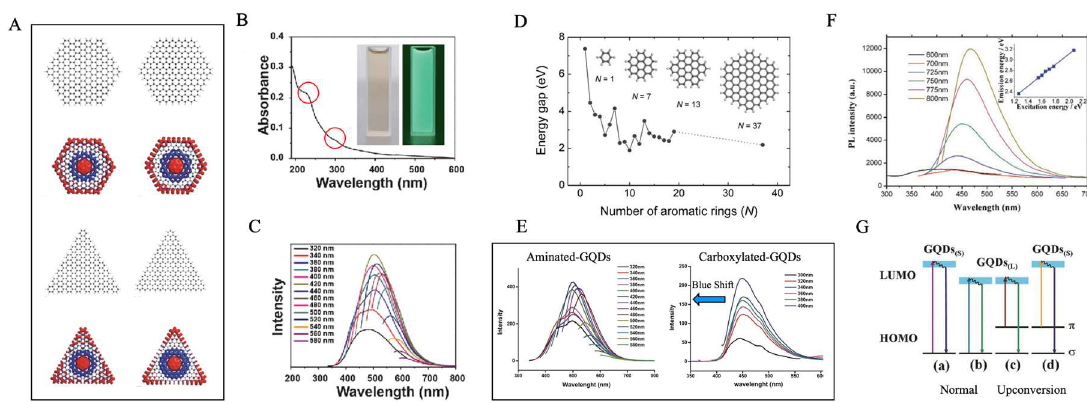
Figure 2. Graphene quantum dots’ optical properties. ( A ) Hexagonal and triangular-shaped graphene quantum dots (GQDs) in two distinct conformations: armchair (left) and zigzag (right), and their relative charge distribution (negative in red and positive in blue). Adapted with permission [6]; ( B ) Typical absorption peaks of GQDs at 230 and 300 nm. Adapted with permission from The Royal Society of Chemistry [31]; ( C ) Photoluminescence (PL) intensity at different excitation wavelengths. Adapted with permission from The Royal Society of Chemistry [31]; ( D ) Reduction of energy gap (red shift) as a function of sp 2 domains. Reproduced with permission [34]; ( E ) Influence of functional groups on PL properties. Amination increases quantum yield, while carboxylation causes blue shifts due to the clusterization of sp 2 domains. Adapted with permission [38]; ( F ) Upconversion of GQDs, showing a reduction in emitted wavelength at higher excitations [41]; ( G ) HOMO-LUMO transitions for big GQDs (b,c) and smaller GQDs (a,d). F and G were reproduced with permission from The Royal Society of Chemistry [41].